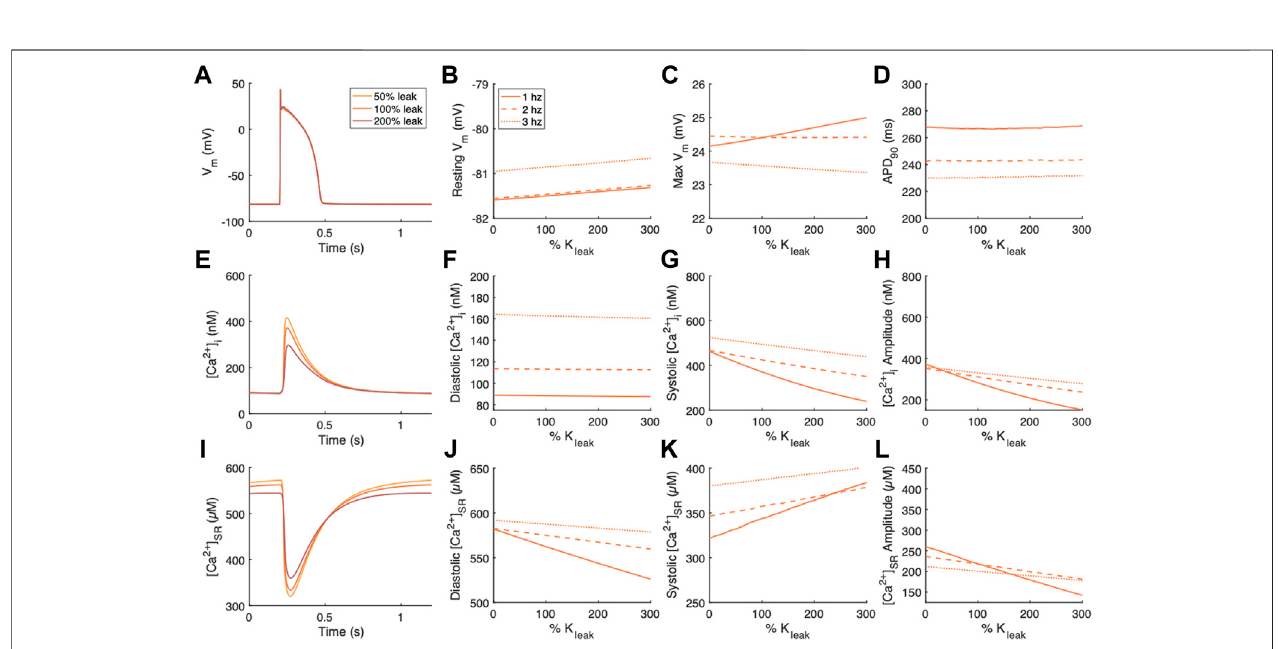
FIGURE 3 | Effects of modulating the SR Ca 2+ leak fl ux, J leak, on V m , [Ca 2+ ] i , and [Ca 2+ ] SR. (A) Example action potentials for 50% and 200% K leak at 1 Hz pacing. Sensitivity analyses of modulating K leak on measurements of (B) resting V m , (C) maximum V m , and (D) time to 90% repolarization at 1, 2 and 3 Hz pacing. (E) Example [Ca 2+ ] i transients for 50% and 200% K leak at 1 Hz pacing. Sensitivity analyses of modulating K leak on measurements of (F) diastolic [Ca 2+ ] i , (G) systolic [Ca 2+ ] i , and (H) [Ca 2+ ] i amplitude at 1, 2 and 3 Hz pacing. (I) Example [Ca 2+ ] SR transients for 50% and 200% K leak at 1 Hz pacing. Sensitivity analyses of modulating K leak on measurements of (J) diastolic [Ca 2+ ] SR , (K) systolic [Ca 2+ ] SR , and (L) [Ca 2+ ] SR amplitude at 1, 2 and 3 Hz pacing.